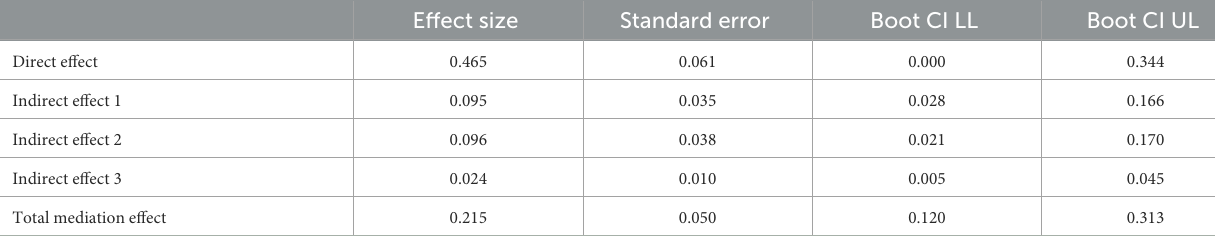
TABLE 4 Analysis of the mediating effect of perceived stress and health promoting